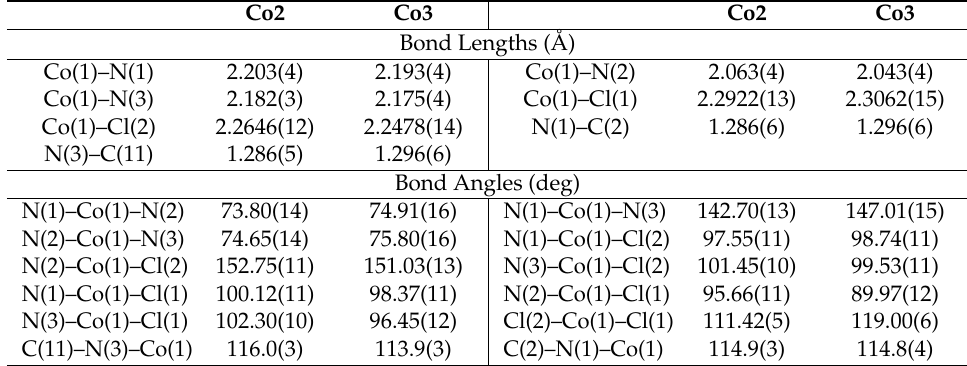
Figure 1. ORTEP drawing of Co2 ( a ) and Co3 ( b ) with thermal ellipsoids at the 30% probability level. Hydrogen atoms are omitted for clarity. Table 1. Selected bond lengths (Å) and angles (°) for Co2 and Co3.